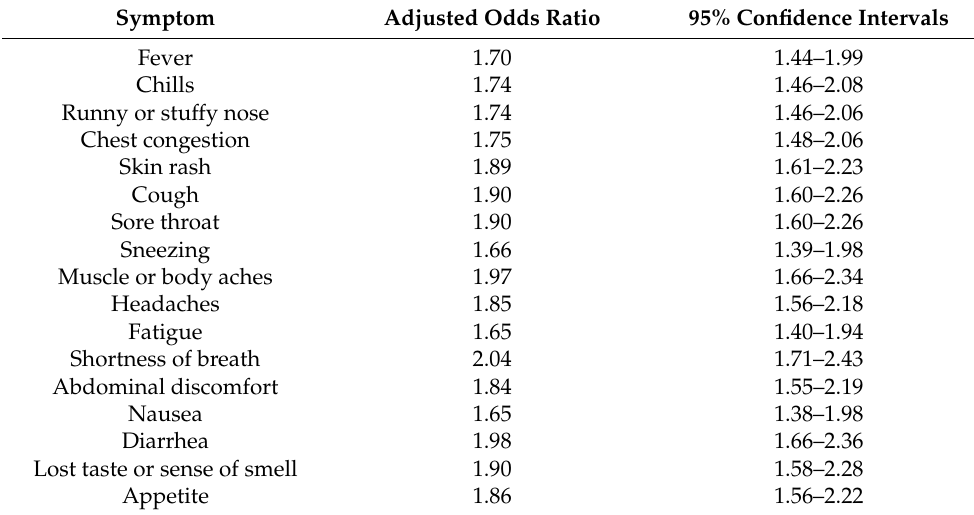
Table 3. Odds and 95% CI of adults with allergies reporting a physical symptom within the last 7 days.